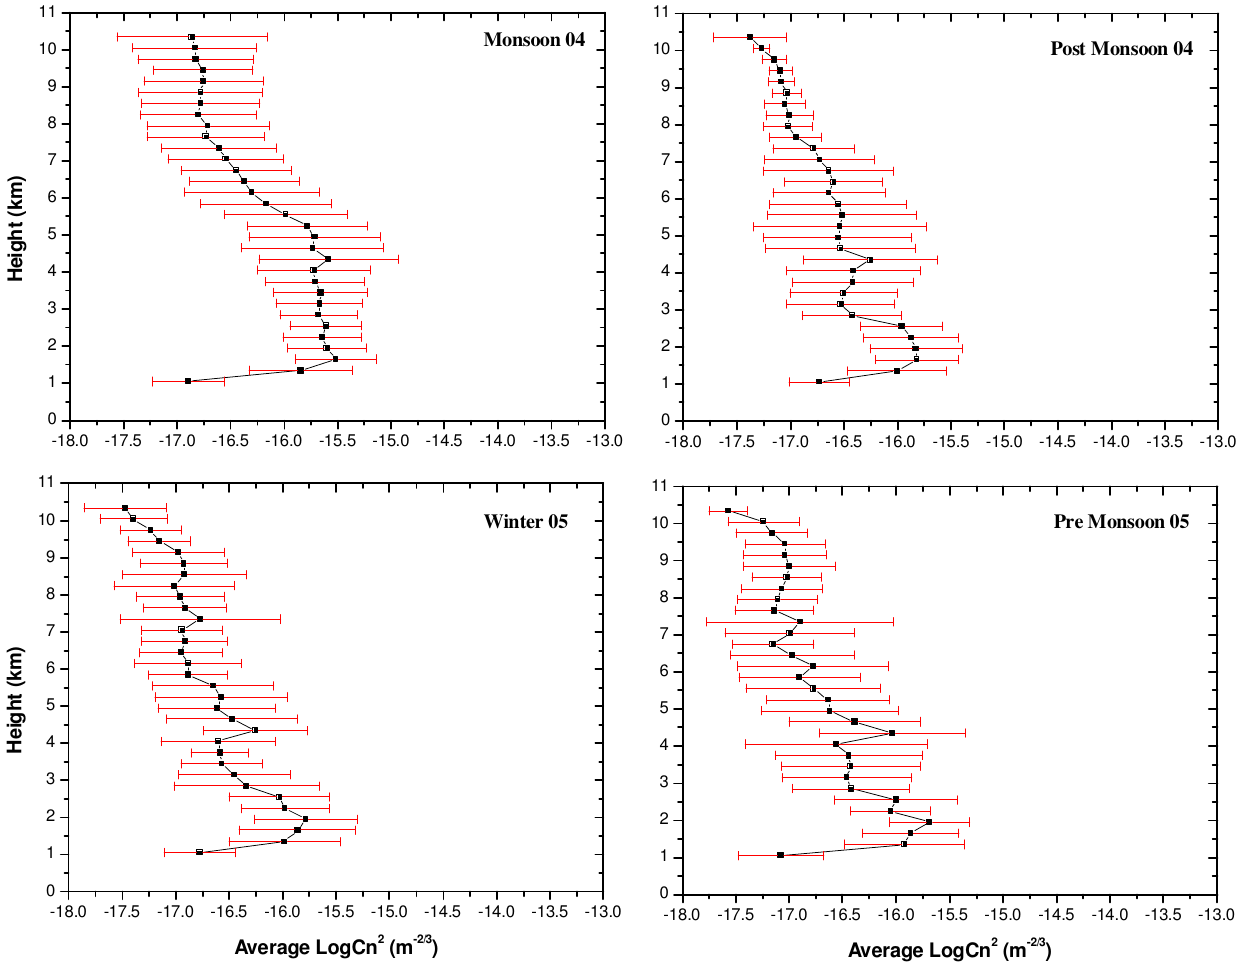
Fig. 3. Seasonal features with standard deviation, year 2004–2005. Total number of available data points for calculating seasonal mean and standard deviation are 77 (for monsoon 2004, the upper left panel), 67 (for post-monsoon 2004, upper right panel), 56 (for winter 2005, bottom left panel), and 73 (for pre-monsoon 2005, bottom right